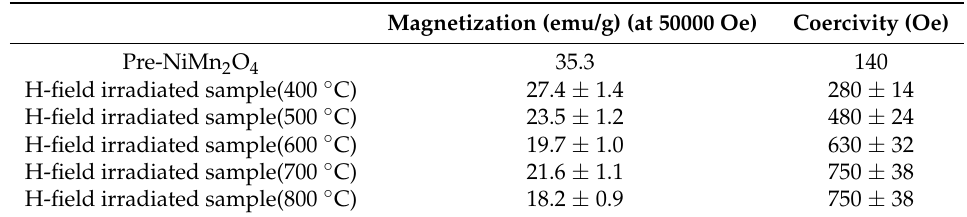
Table 2. Magnetic properties of NiMn 2 O 4 irradiated with microwave H-field at different temperature. Magnetization (emu/g) (at 50000